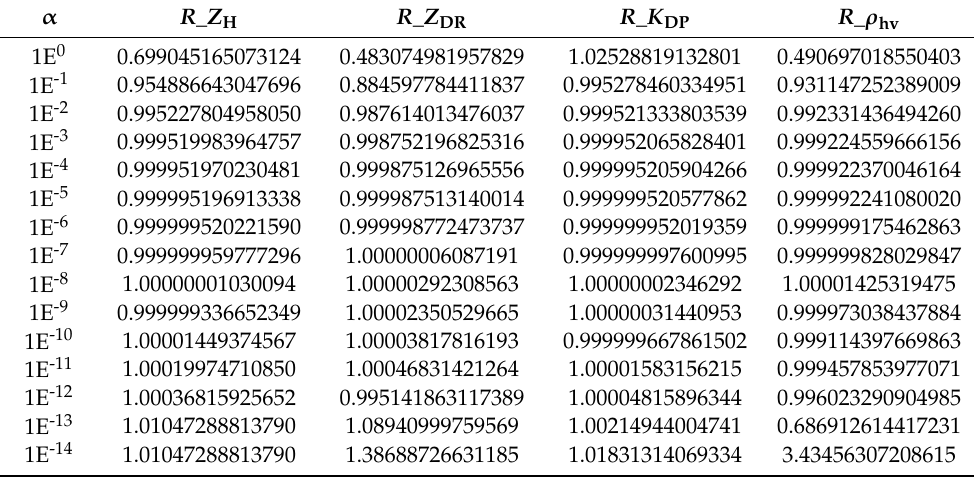
Table 1. Results of test for Z21 TL/AD